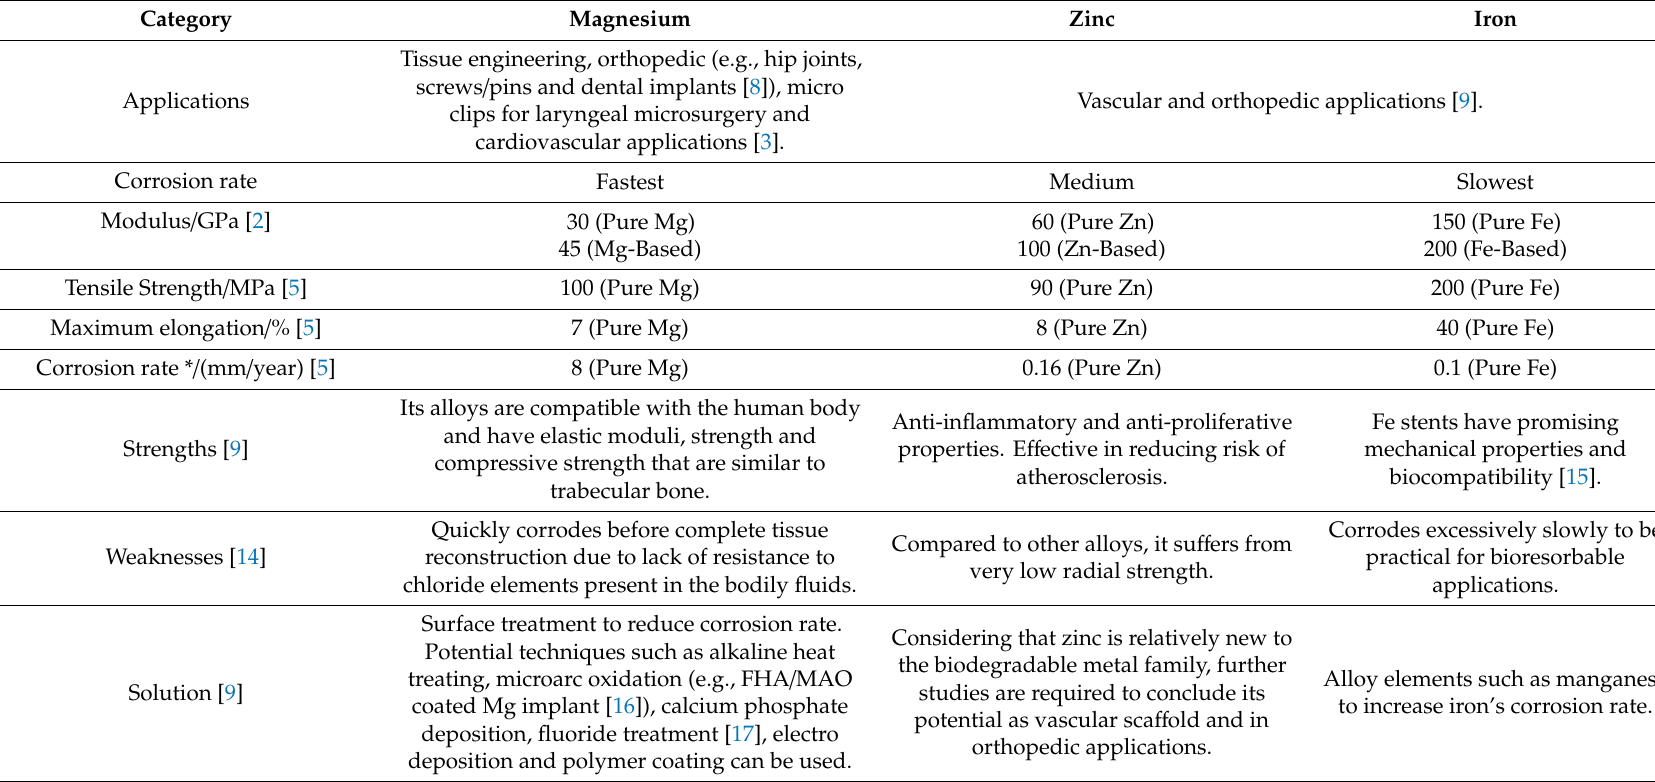
Table 1. Summary comparison of the three biodegradable metals for implants. * Corrosion rate data obtained from identical experiments, i.e., conducting polarization test in 37 ◦ C simulated body fluid. Values might change depending on testing condition and